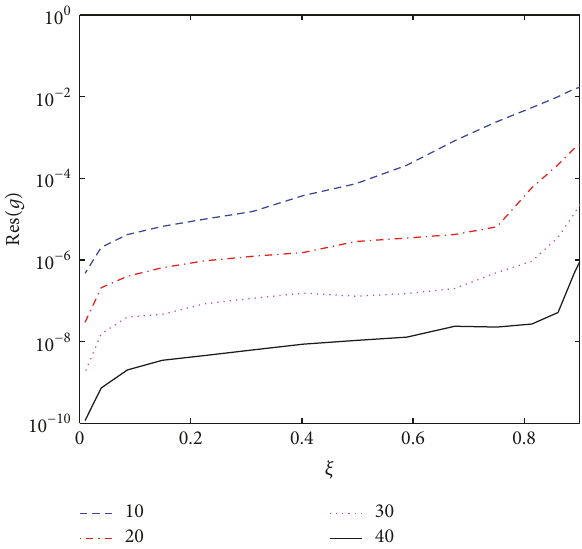
Figure 4: Residual error in 𝜙(𝜂,𝜉) against ℏ at different iteration levels ( 𝜆 = 1, 𝜎 = 𝛾 = 0.5, Pr = 3, Sc = 2, 𝜉 = 0.45 ).